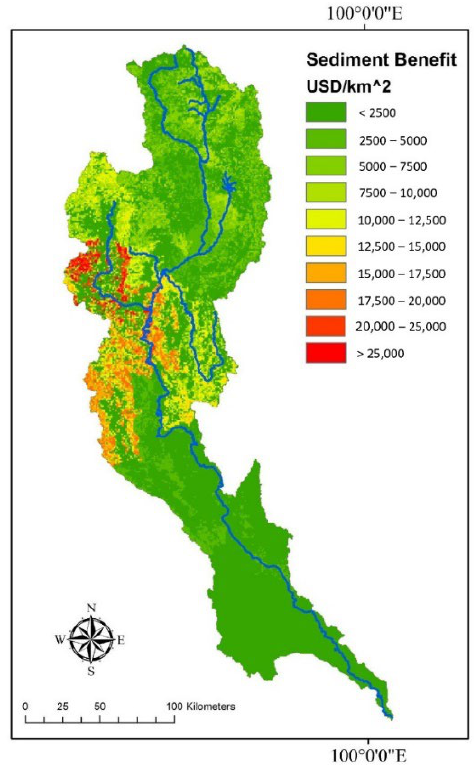
Figure 12. Potential of sediment benefits. Figure 11. Potential of sediment costs.